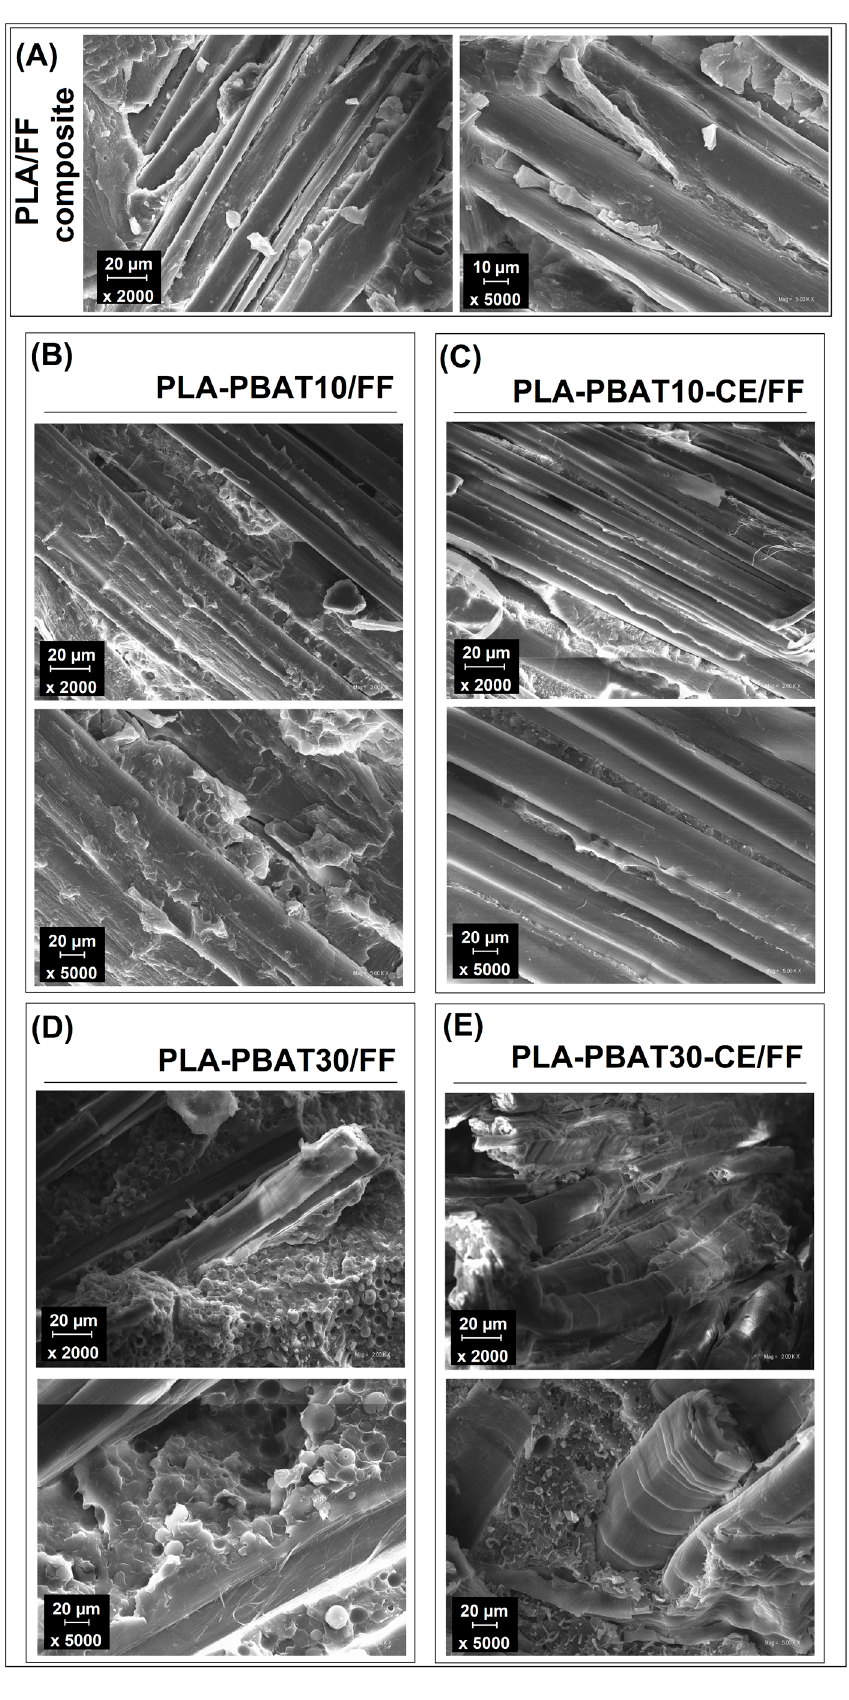
Figure 10. Structure of the FF reinforced composites. ( A ) PLA/FF samples, ( B )